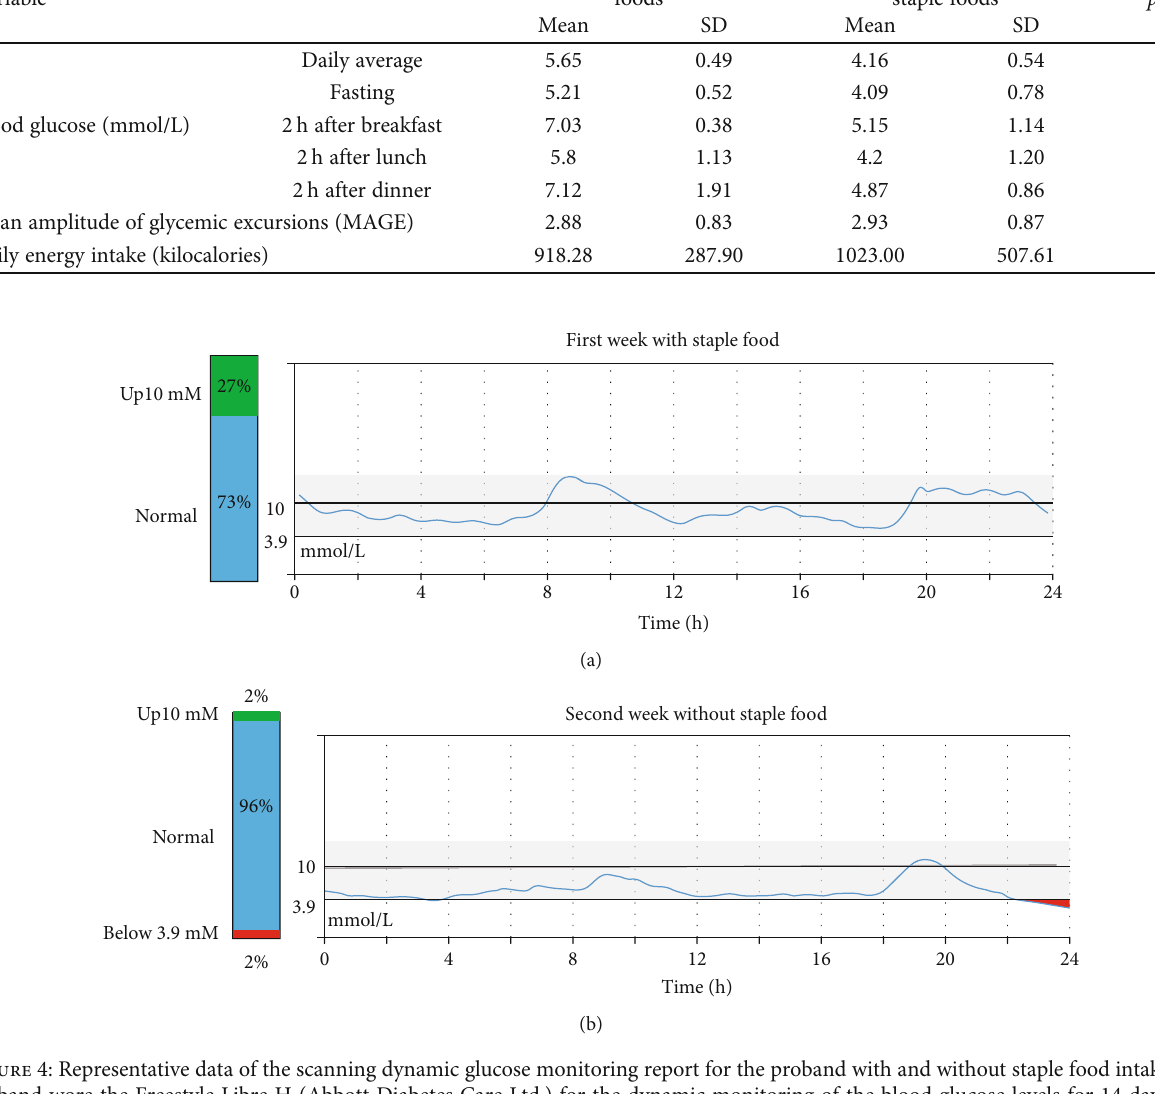
First week with staple Second week without foods staple foods p value Mean SD SD